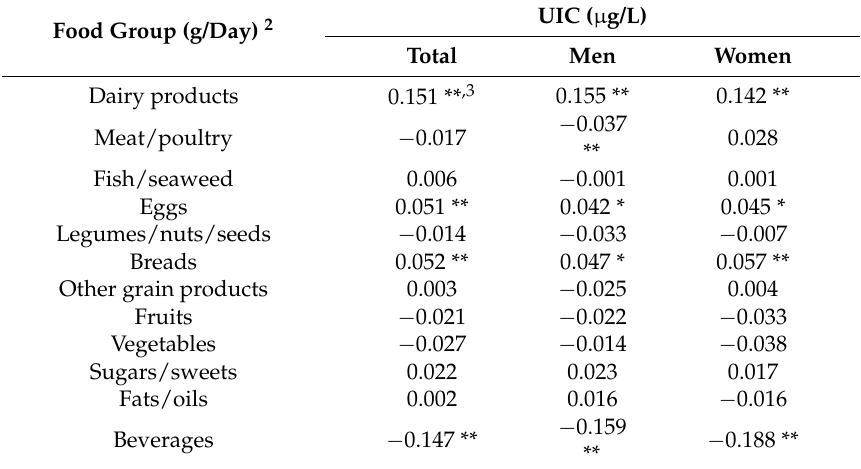
Table 2. Correlation coefficients between urinary iodine concentration and food group intakes in US adults, NHANES 2007–2012 1 .